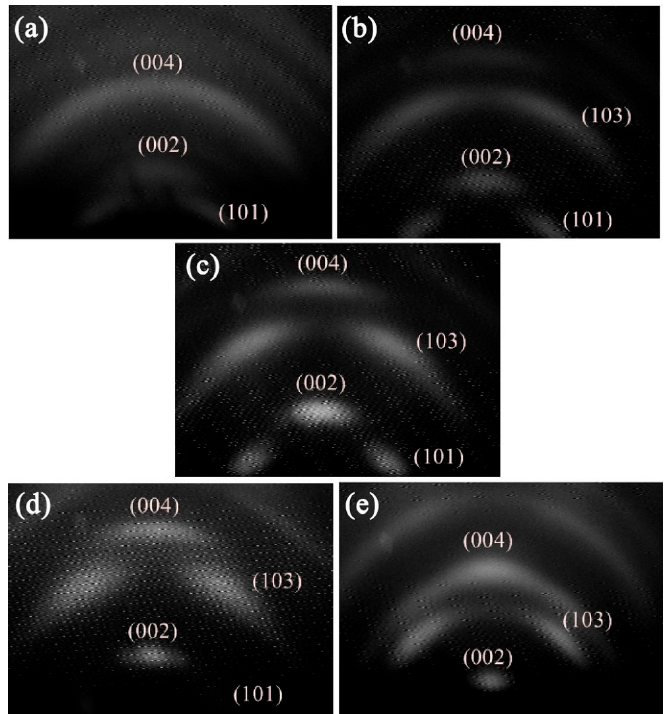
Figure 1. Reflection high-energy electron diffraction (RHEED) patterns of the InN thin films deposited at ( a ) 200 °C, ( b ) 300 °C , ( c ) 400 °C , ( d ) 500 °C and ( e ) 600 °C .